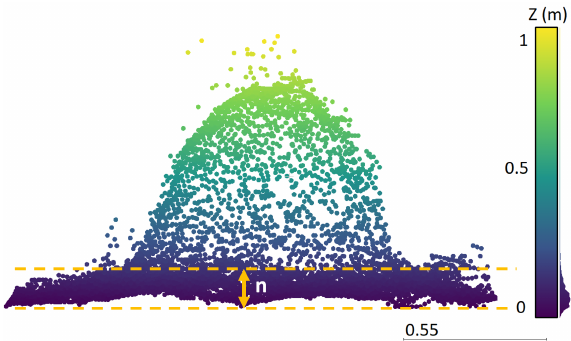
Figure 7. Rasterized point cloud for volume calculation (UAV-LS (HR)). The cuboids that are used to estimate the volume are confined by the top line and the termite mound. The bottom line represents the average height of the lowest 20 points. The value of n was optimized to prevent over- or under-estimations of termite mound